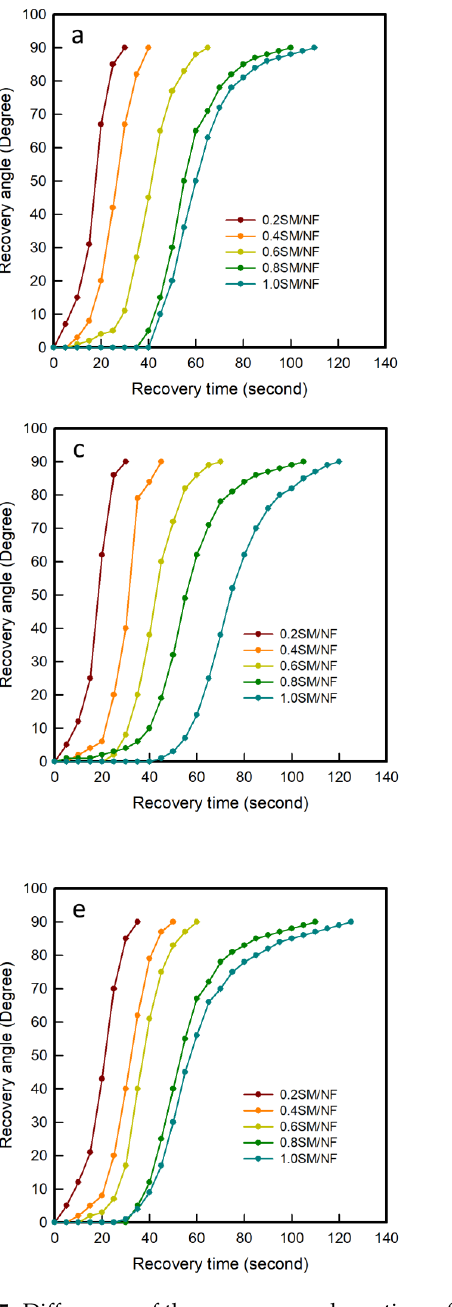
Figure 5. Differences of the recovery angle on time of 3D-printed sinusoidal sample/nylon composite with various thicknesses during the ( a ) 1st cycle, ( b ) 10th cycle, ( c ) 20th cycle, ( d ) 30th cycle, ( e ) 40th cycle, and ( f ) 50th cycle.